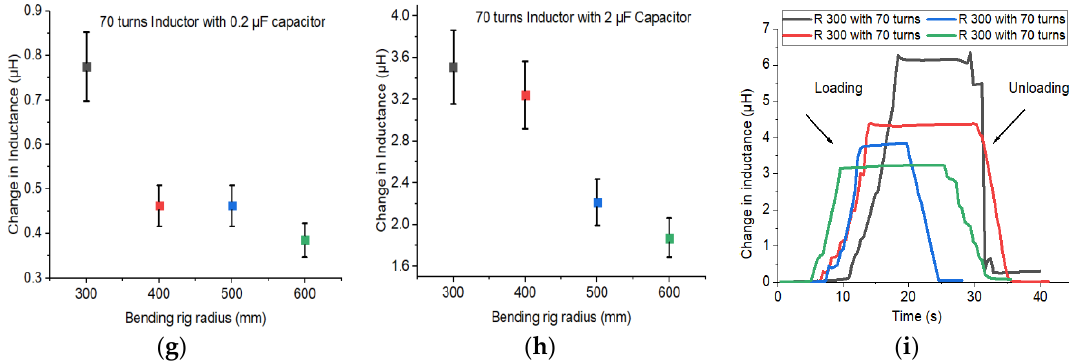
Figure 10. ( a – i ) Change in inductance results of the bending rig test for composite with CoSiB ribbon on top ( a , d , g ) represents these results for 0.2 µF capacitor; ( b , e , h ) represents these results for 2 µF capacitor and ( c , f , i ) represents change in inductance results obtained from the RLC meter.